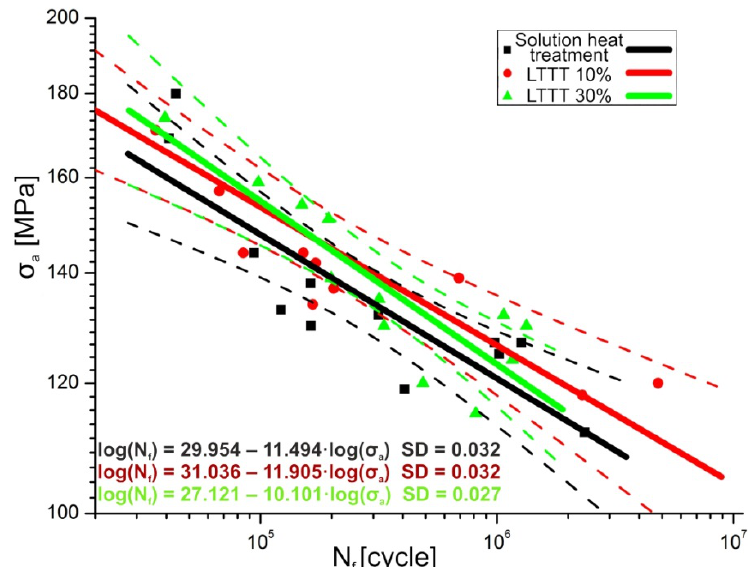
Figure 3. Basquin’s diagram of regression lines with confidence intervals α = 0.05 (dotted lines) for AlZn6Mg0.8Zr alloy subjected to the bending - torsion test after various stages of LTTT. SD —standard deviation.